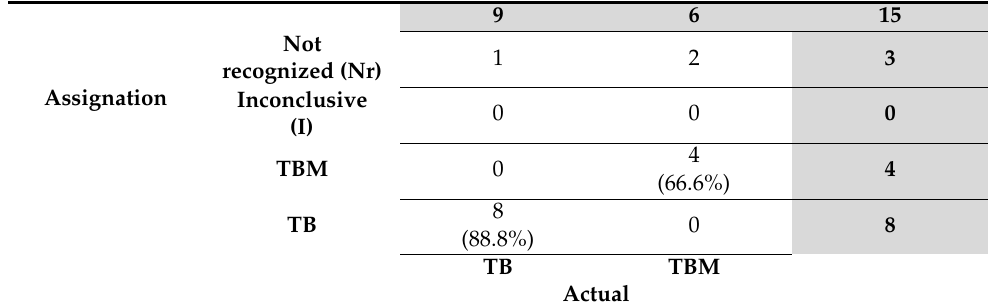
Table 1. Classification of the validation samples using SIMCA.